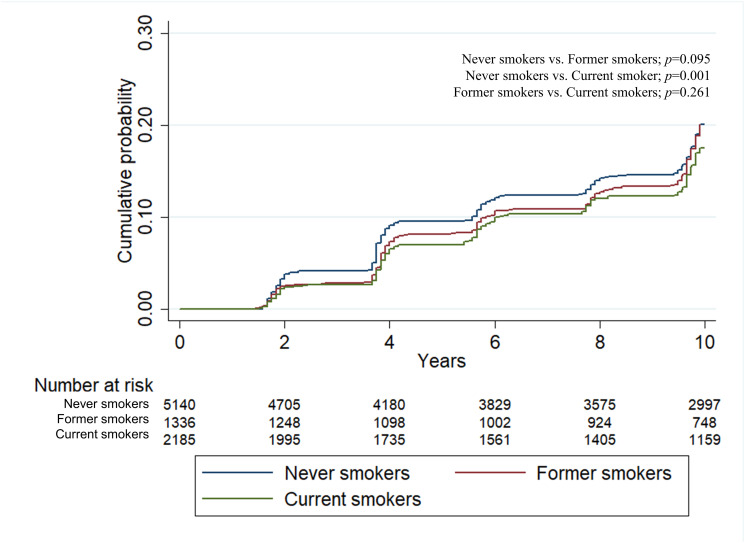
Kaplan-Meier curve for incident CKD.